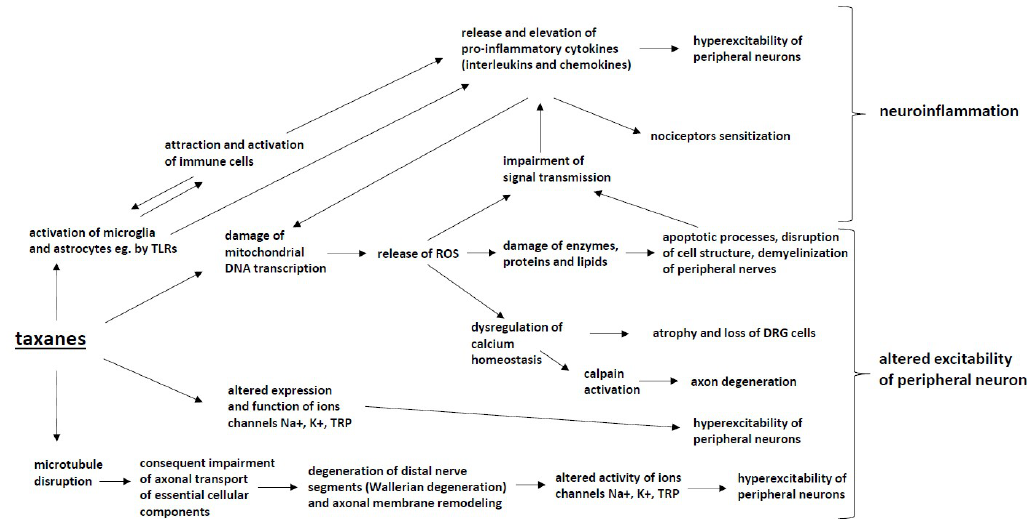
Figure 3. The mechanisms of CIPN induced by taxanes: Taxanes cause microtubule disruption, which impairs axonal transport and leads to Wallerian degeneration, altered activity of ion channels and hyperexcitability of peripheral neurons. Taxanes also modify the expression and function of Na+, K+ and TRP ion channels, which results in the hyperexcitability of peripheral neurons. Taxane-induced mitochondrial damage contributes to the increased production of reactive oxygen species (ROS), which leads to enzyme, protein and lipid damage as well as the dysregulation of calcium homeostasis within neurons, which induces apoptotic changes and the demyelination of peripheral nerves. These processes alter the excitability of peripheral neurons. The activation of microglia and astrocytes by taxanes also leads to the activation of attraction and activation of immune cells and to the release and elevation of pro-inflammatory cytokines (interleukins and chemokines), which results in the nociceptor sensitization and hyperexcitability of peripheral neurons. These processes lead to nociceptor sensitization and the development of